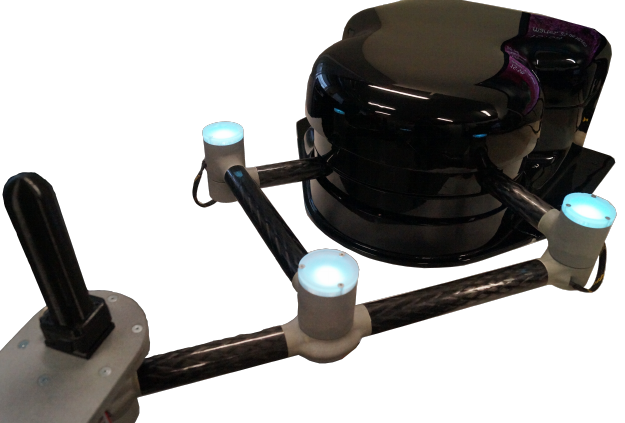
Figure 1. Upper-limb rehabilitation robotic device called Rubidium. Rubidium is commercialized and distributed by the spin-off